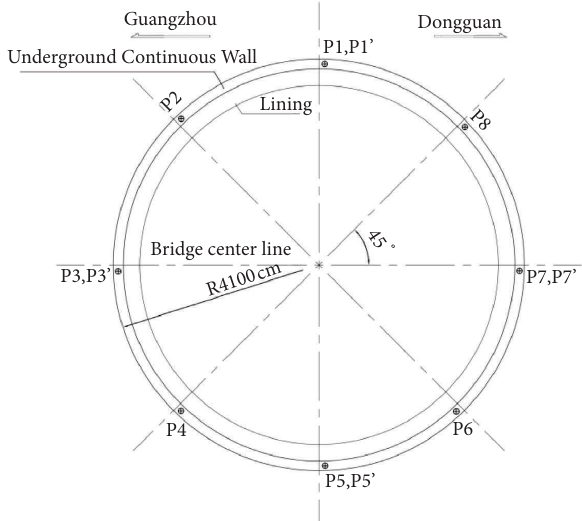
Figure 4: Deep deformation monitoring points for the diaphragm